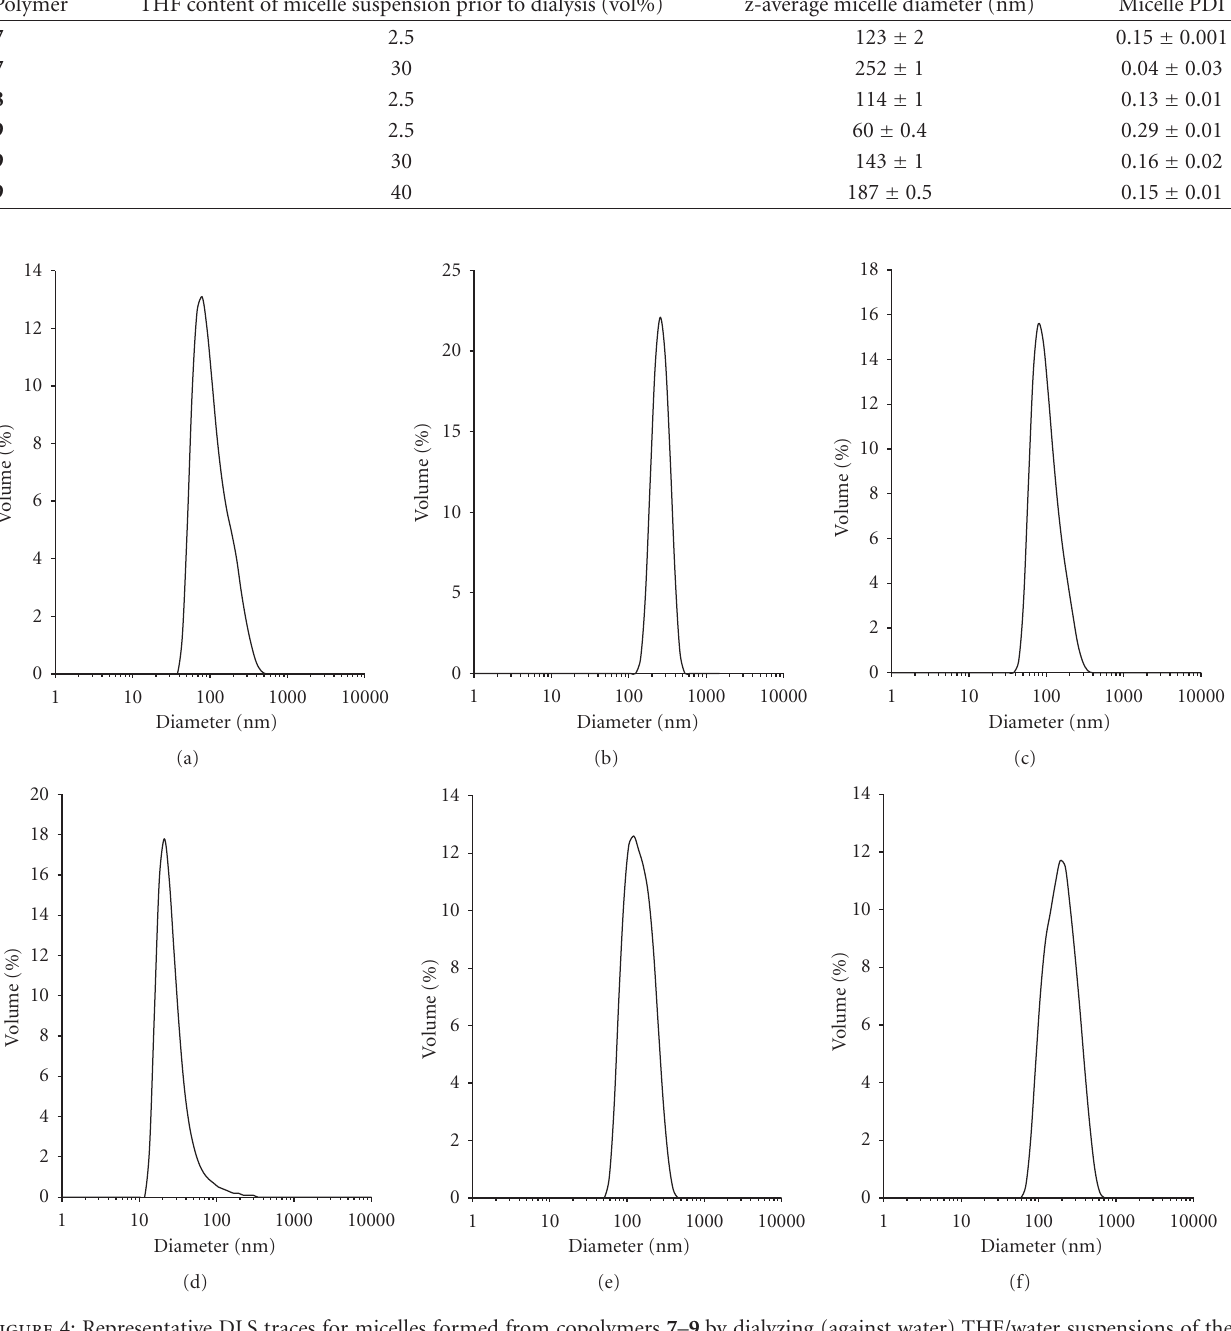
Figure 4: Representative DLS traces for micelles formed from copolymers 7 – 9 by dialyzing (against water) THF/water suspensions of the micelles containing varying THF content: (a) copolymer 7 from 2.5 vol% THF; (b) copolymer 7 from 30 vol% THF; (c) copolymer 8